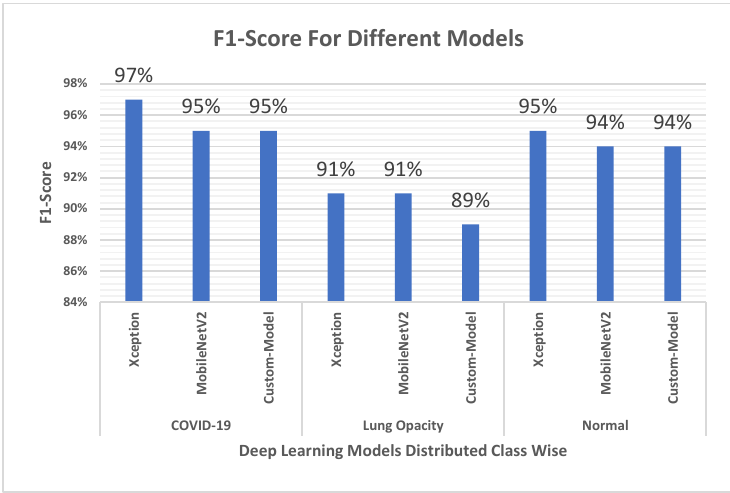
Figure 10. F1 score plot for different models in terms of percentages.